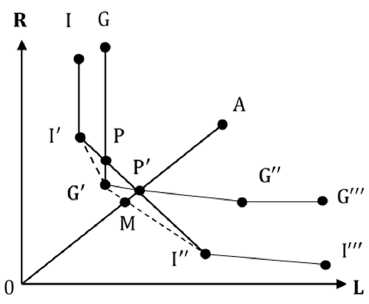
Figure 3. Comparison of pool frontier and metafrontier.